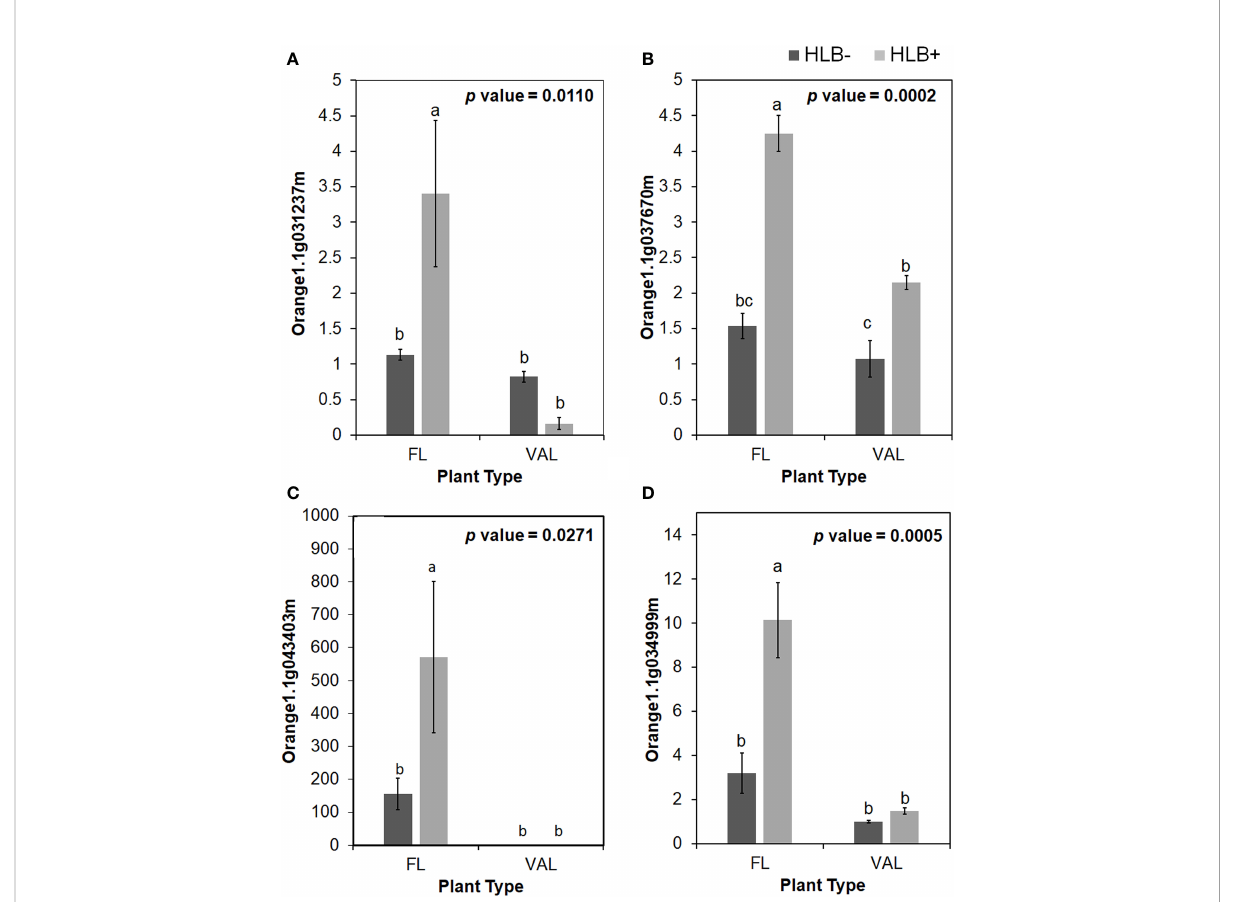
FIGURE 4 Relative transcript levels of CAP (Cysteine-rich secretory proteins; Antigen 5; and Pathogenesis-related 1 protein) superfamily protein is calculated by real-time PCR compared with the Ca Las free ‘ Valencia ’ . (A) CAP1, (B) CAP2, (C) CAP3 and (D) LCR69. The Ca Las infected samples were collected from fi ve years old samples growing in the fi eld and the Ca Las free (control) samples were collected from a protected greenhouse. The control samples were con fi rmed negative for Ca Las before further comparison. Data are means±SE of twelve samples. Different letters above the error bar indicate statistically signi fi cant differences, while the same letters signify no signi fi cant differences using the Tukey-Kramer honestly signi fi cant difference test (Tukey HSD; p